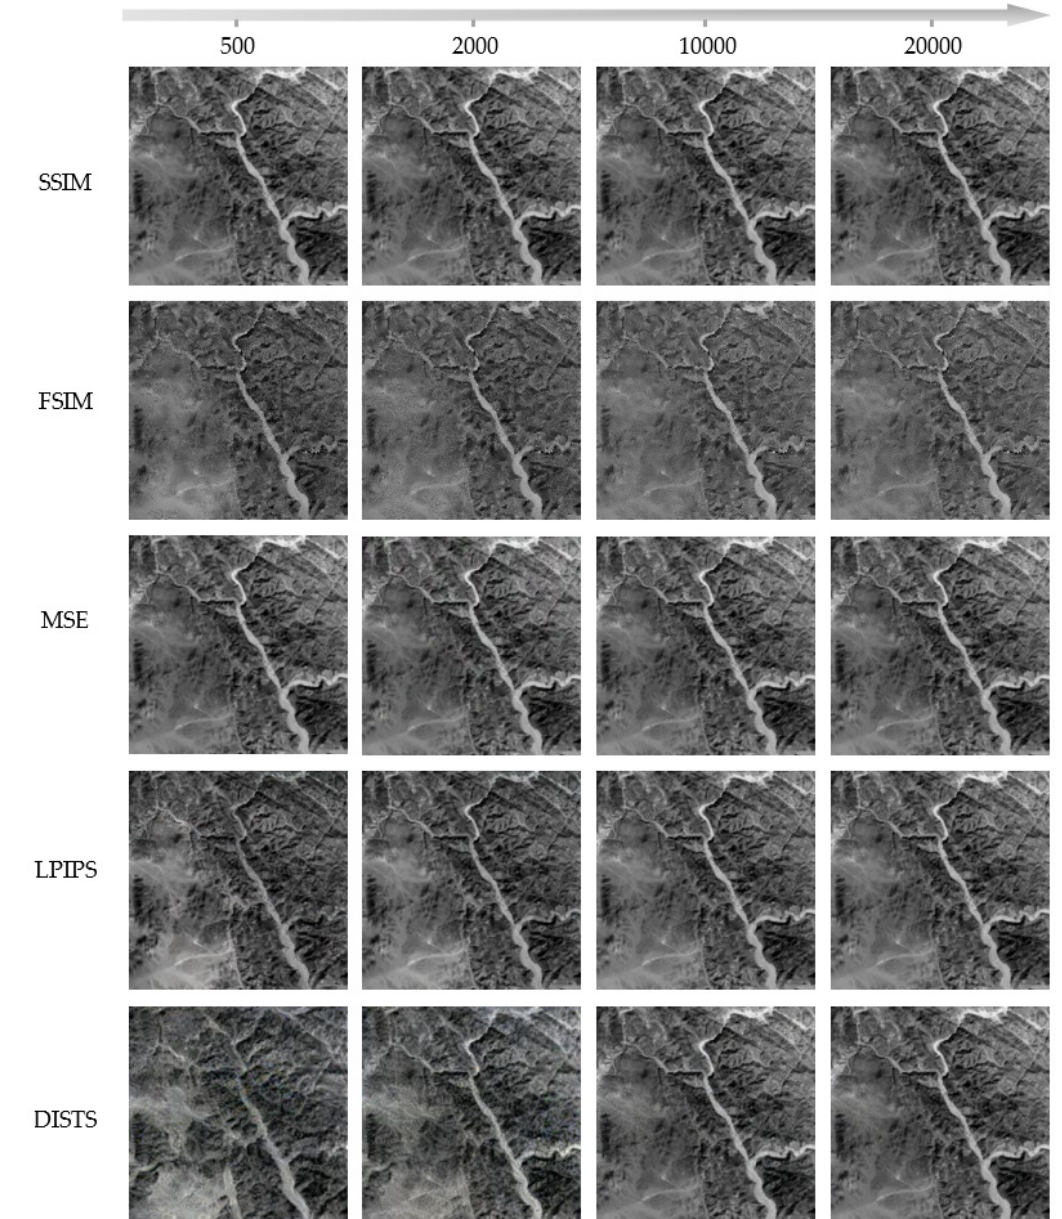
Figure 7. Distorted Gorge recovery obtained by different models at 500, 2000, 10,000 and 20,000 Figure7. DistortedGorgerecoveryobtainedbydi ff erentmodelsat500, 2000, iterations.